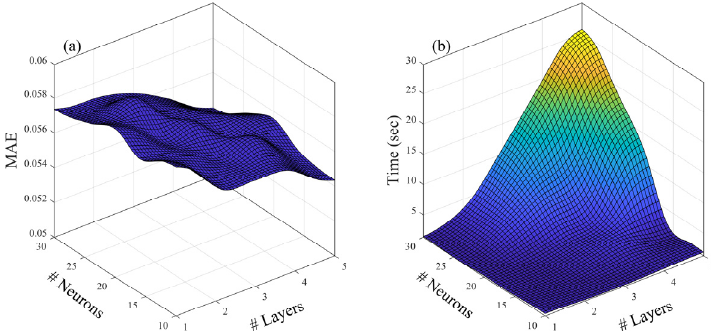
Figure 21. ( a ) MAE and ( b ) computation run time for the training stage of the DFuSIAL method for different combinations of the number of layers and neurons in each hidden layer within the SFANN. The surfaces created by interpolation over the observed values from the 25 combinations in the experiment.